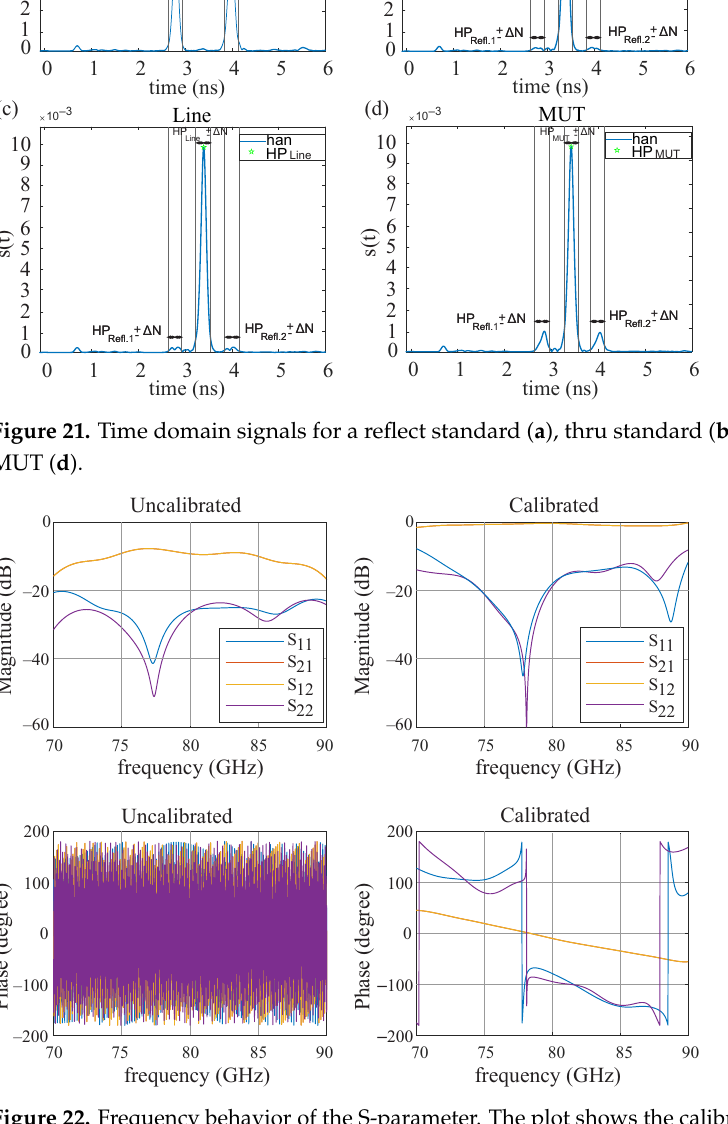
Figure 22. Frequency behavior of the S-parameter. The plot shows the calibrated ( right side ), as well as the uncalibrated ( left side ) result of a lossless 2 mm thick sample with a permittivity of